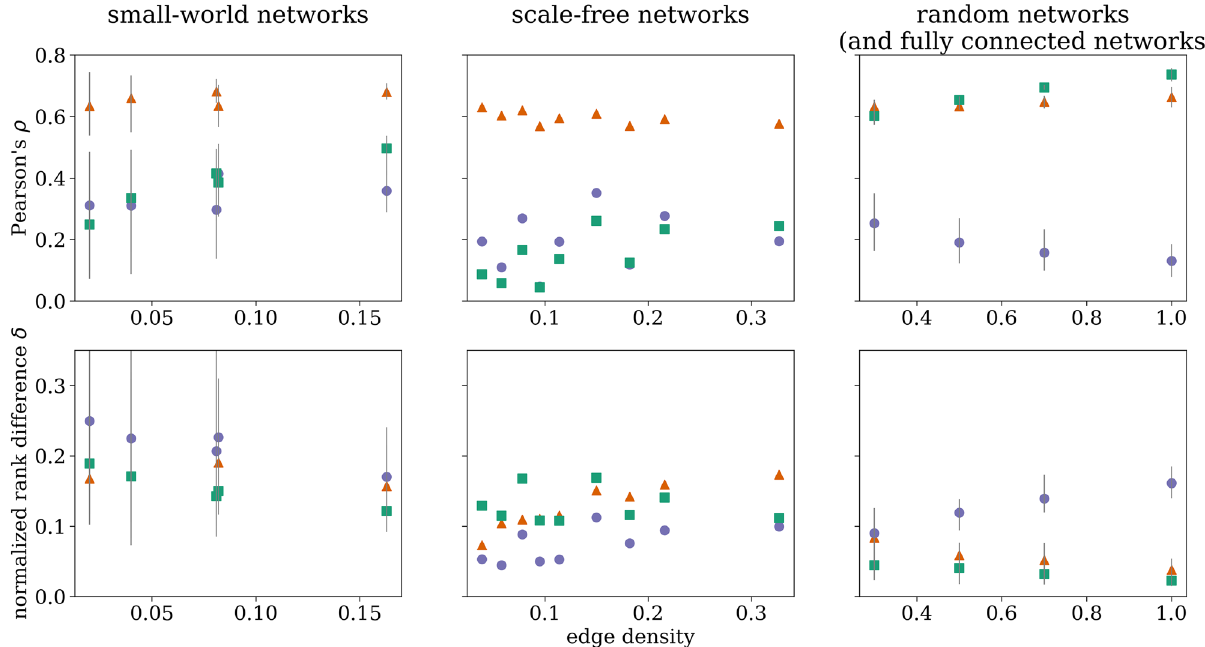
Figure 1. Nearest-neighbor edge centrality provides non-redundant information about edges in paradigmatic network models. Correlations (Pearson’s ρ ) of edge ranks (top) and normalized rank differences δ (bottom) obtained with the different centrality metrics for the investigated network topologies and edge densities. Means and ranges (lengths of error bars) obtained from 100 realizations of the network topologies. Different colors encode pairs of edge centralities used for correlation analyses and analysis of normalized rank differences: orange triangle—( C N e , C B e ), purple circle—( C N e , C C e ), and green square—( C N e , C E e ). Note that for scale-free networks error bars are smaller than symbol